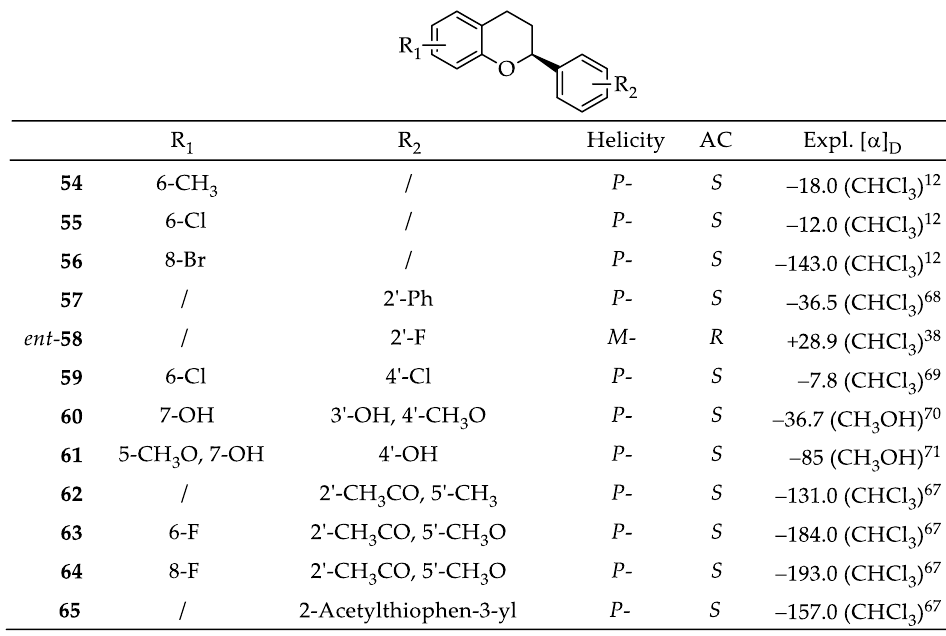
Figure 7. Experimental and predicted [α] D values for chiral 2-aryl chromanes 54 – 65 . Experimental SOR data were collected from references [12,38,67 – 71].